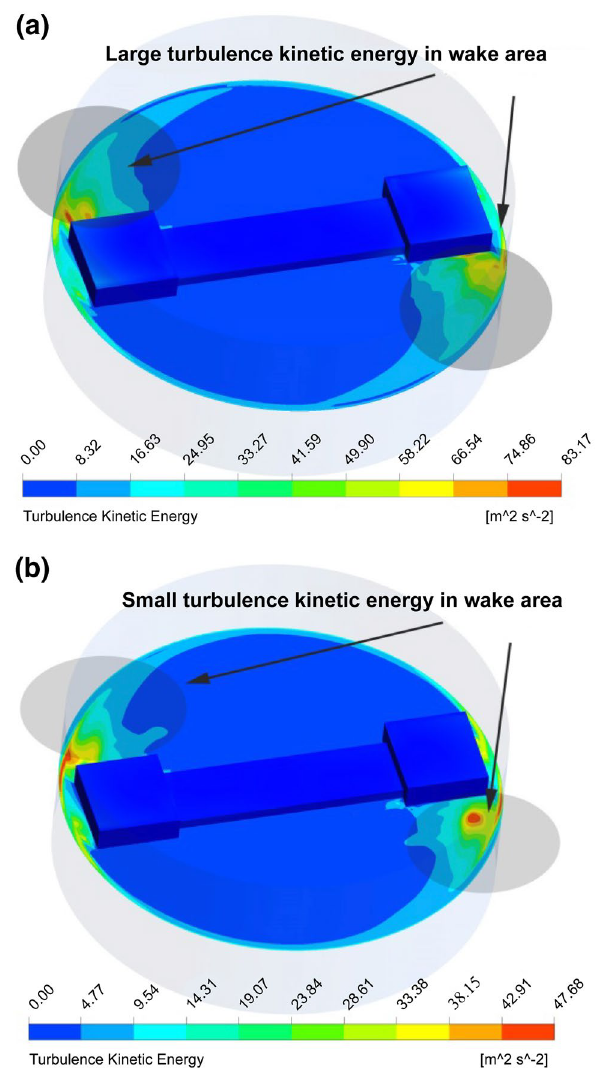
Fig. 14 Cloud diagram of the turbulent kinetic energy at a 5000 Pa and b atmospheric